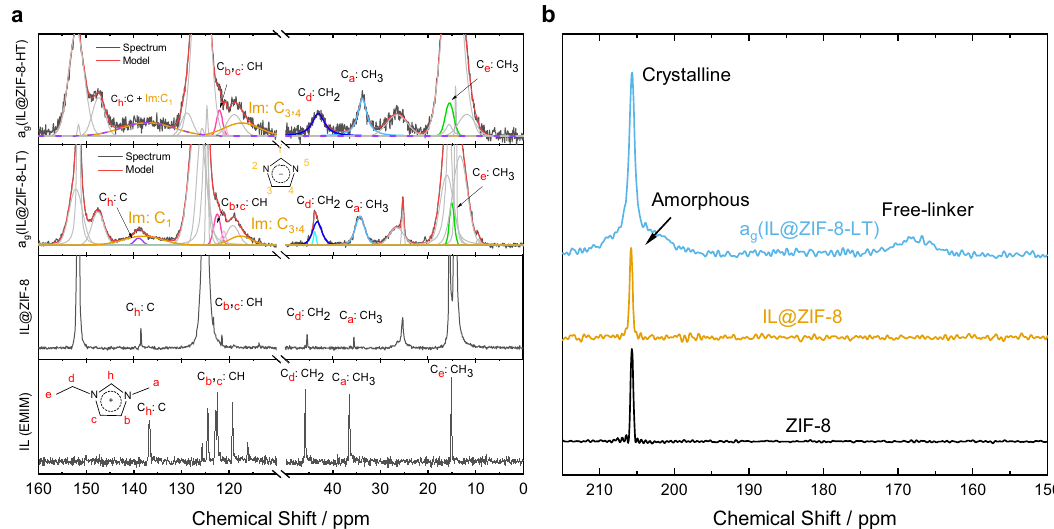
Fig. 5 NMR analysis of EMIM carbons and mIm nitrogen of the ZIF-8 linker. a EMIM NMR Signatures Comparison. Decoupled 13 C SSNMR of IL, 1 H- 13 C CP SSNMR of IL@ZIF-8, a g (IL@ZIF-8-LT), and a g (IL@ZIF-8-HT). Pronounced broadening and shifting of the IL carbon peaks in a g (IL@ZIF-8-LT) and a g (IL@ZIF-8-HT) con fi rms immobilization of the IL and collapse of ZIF-8 pores at elevated temperatures. For clarity, IL cation peaks are highlighted, while the ZIF-8 peaks are grayed out in the heat-treated samples. In the a g (IL@ZIF-8-LT) and a g (IL@ZIF-8-HT) spectra appearance of Im cations can be observed in gold. b 1 H- 15 N CP NMR Comparison of ZIF-8, IL@ZIF-8, and a g